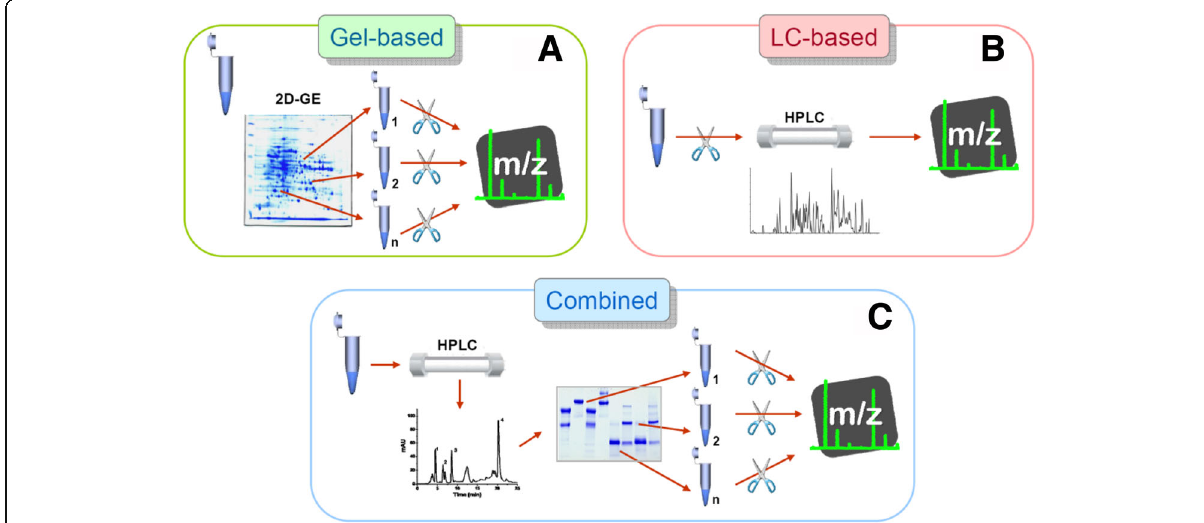
Fig. 1 General types of analytical bottom-up strategies employed in the proteomic profiling of snake venoms. a Gel-based strategies involve the separation of the venom proteins by two-dimensional gel electrophoresis (2DE) followed by staining and spot picking. Protein spots are then in-gel digested (usually with trypsin, scissors icon) and the resulting proteolytic peptides submitted to tandem mass spectrometry (MS/MS) analysis. b Liquid-chromatography (LC)-based strategies (shotgun proteomics) digest the whole venom with trypsin and separate the resulting peptides usually by multidimensional nano-flow HPLC, hyphenated to MS/MS analysis. c The combined strategy of ‘ snake venomics ’ takes advantage of the opportunity of performing the fractionation and the quantification of the venom components in the same reversed-phase chromatography step. A second step of separation and quantification is performed by SDS-PAGE followed by gel densitometry. Protein bands are excised, in-gel digested with trypsin, and submitted to MS/MS